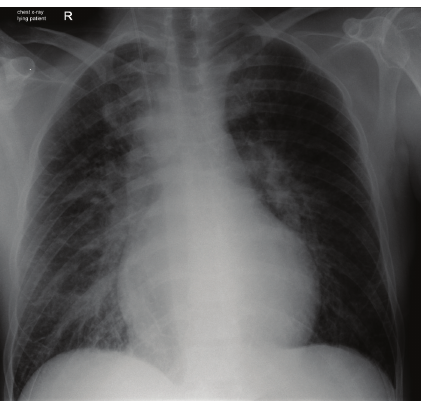
Figure 1: Chest X-ray of the lying patient in the a.p. path of ray. The congestion of the pulmonary veins reflects the cardiac shock and mild pulmonary edema. A meso-/dextrocardia with a dilated heart silhouette is the prominent finding.